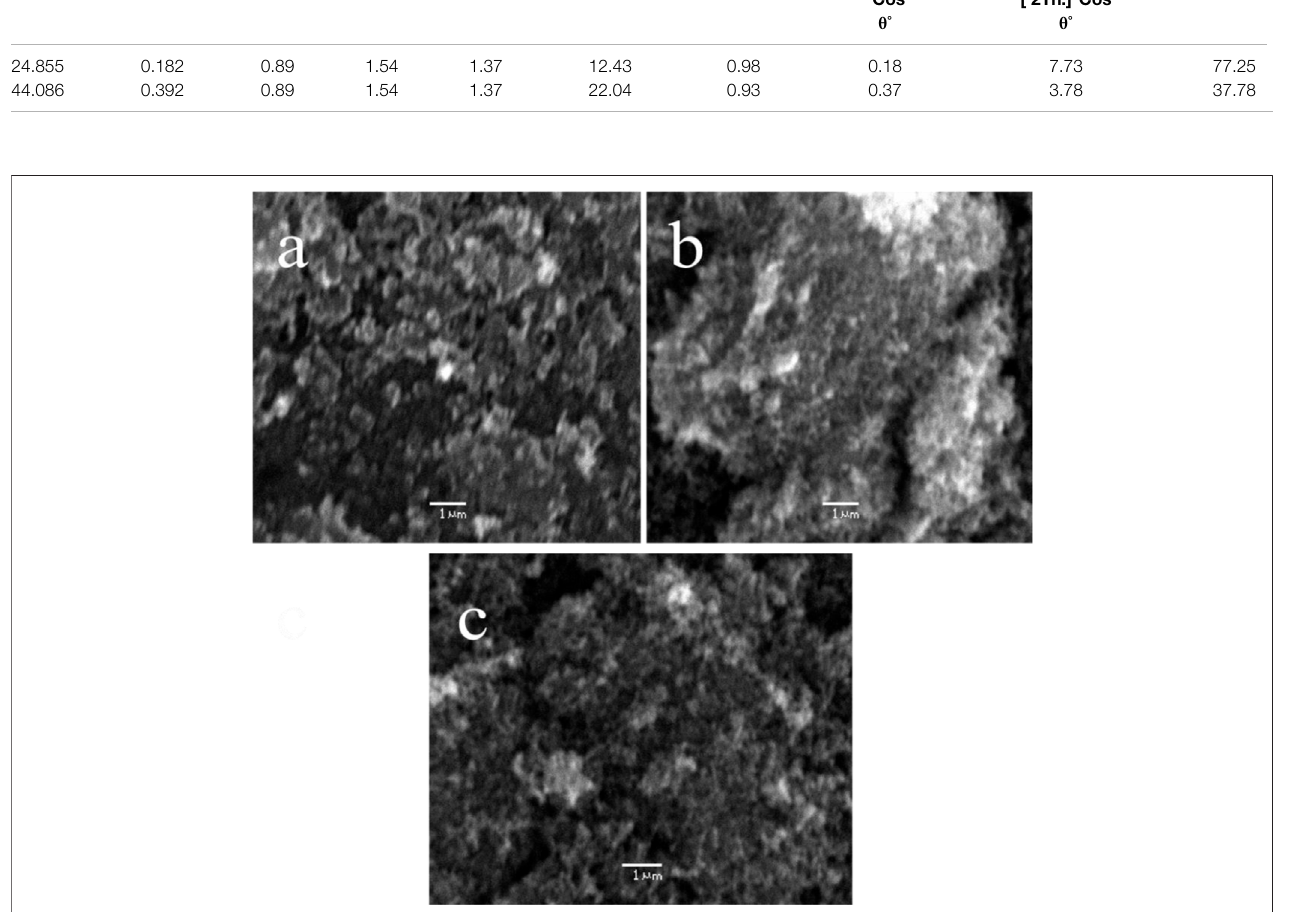
FIGURE 2 | SEM micrographs of carbon nanoparticles synthesized from (A) mustard oil (B) olive oil and (C) linseed oil.